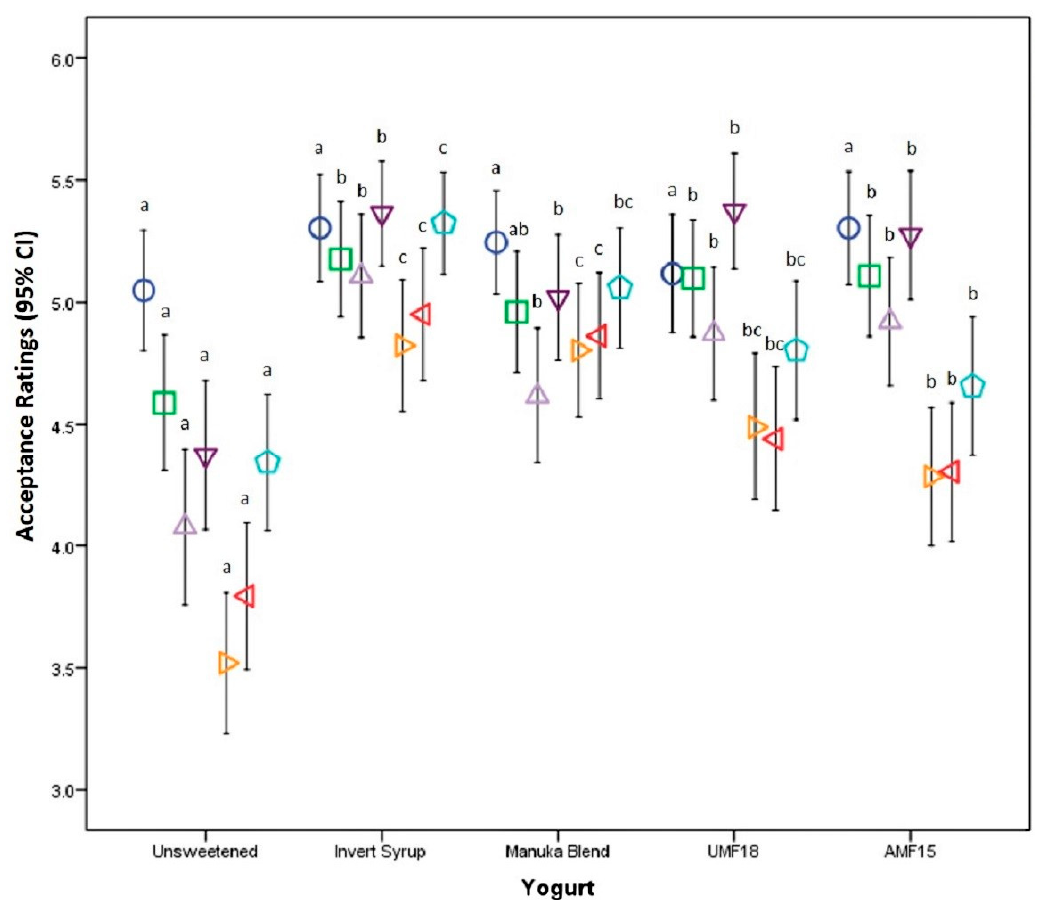
Figure A1. Error Bars of sensory acceptance ratings in 95% Confidence Intervals (CI) for yogurts with three different manuka honey and controls. Attributes: Colour ( ), Appearance ( ), Mouthfeel ( ), Smoothness ( ), Sweetness ( ), Sourness ( ); Overall acceptability ( ). Different lowercase letters indicate significant differences ( p < 0.05) in the sensory rating (across the different yogurt samples).